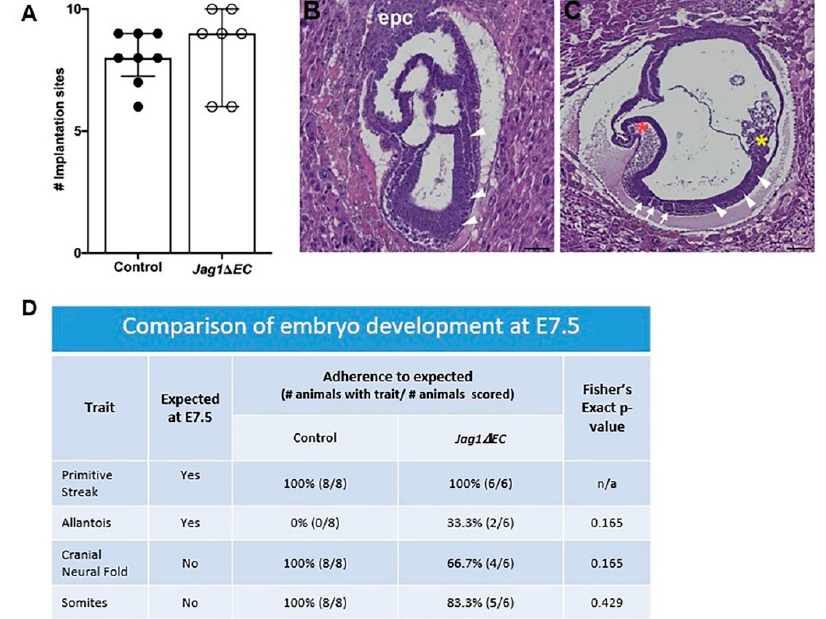
Figure 5. EC-specific loss of Jag1 does not disrupt pregnancy progression or litter size at E7.5. ( A ) Number of implantation sites at E7.5 is similar between controls ( n = 8) and Jag1 ∆ EC